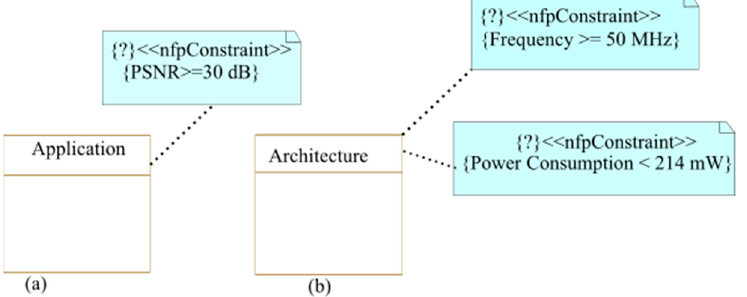
Figure 7. System specification modeling: ( a ): application constraints and ( b ): architectural con-